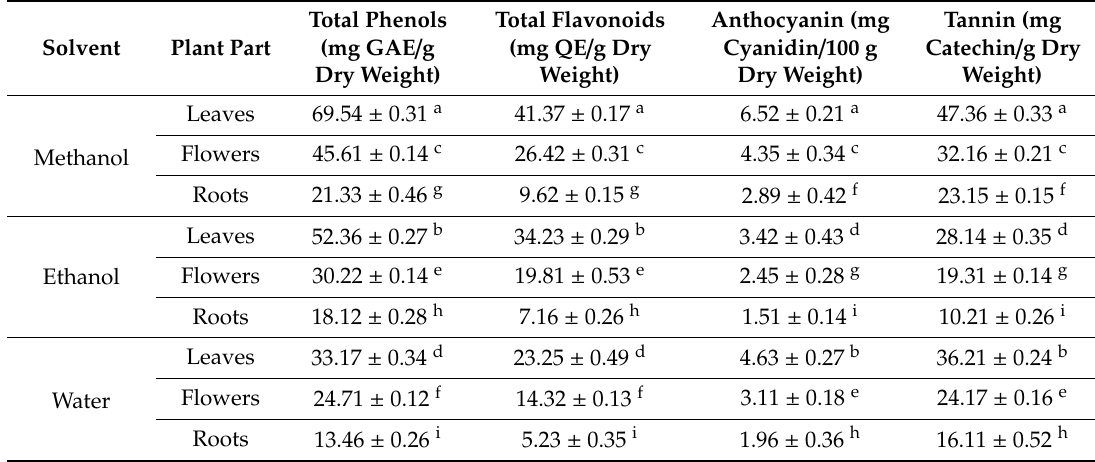
Table 1. The total phenols, total flavonoids, anthocyanin, and tannin concentrations in the di ff erent extracts of Nepeta